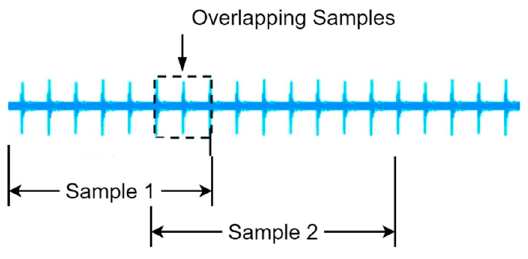
Figure 6. Sample Expansion Diagram.